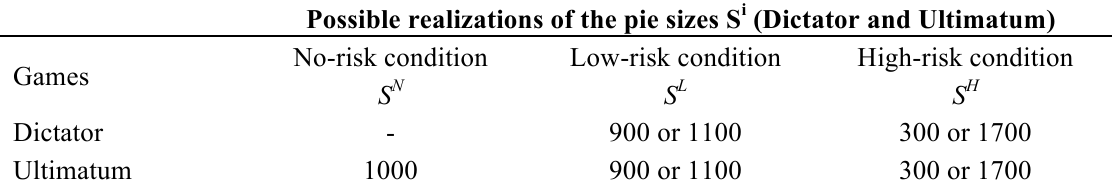
Table 1. Operationalization of endowment risk.